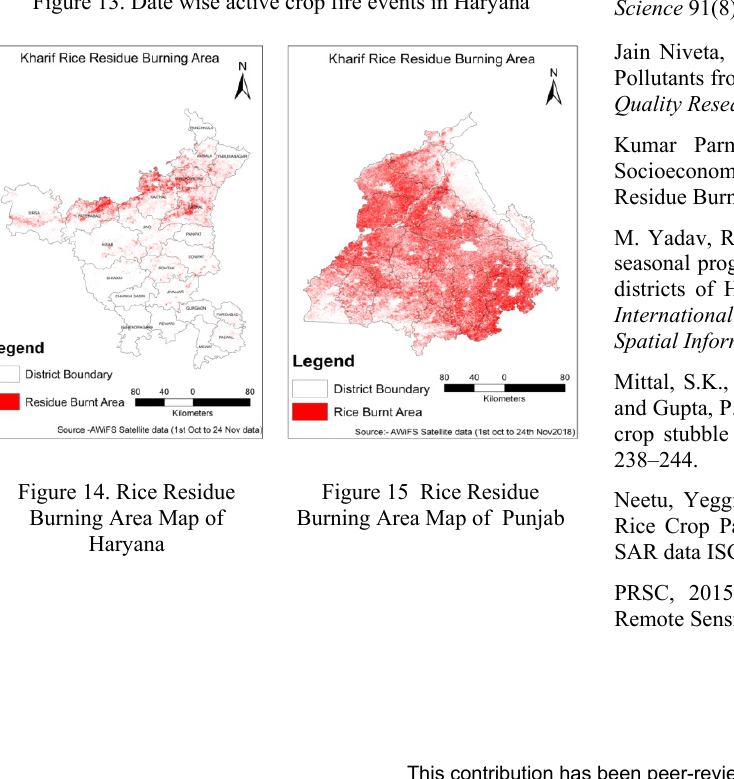
Figure 15 Rice Residue Burning Area Map of